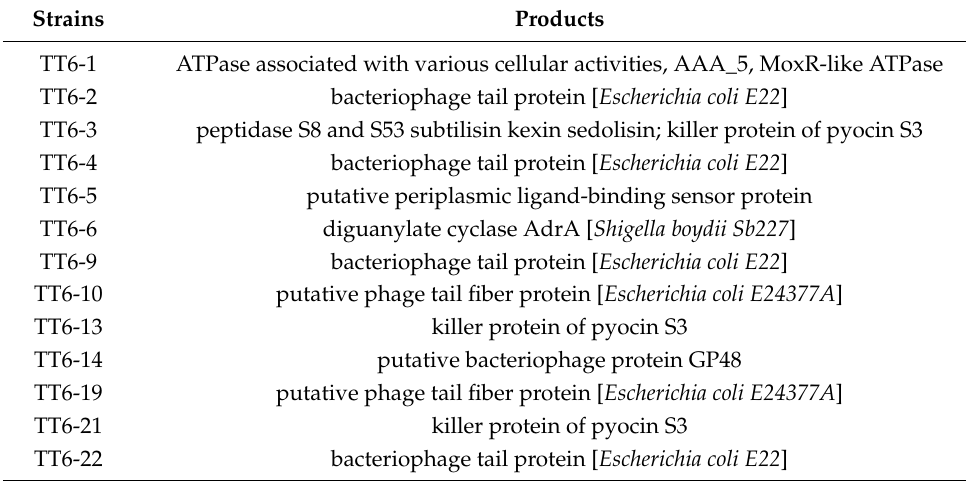
Table 1. List of genes identified by transposon